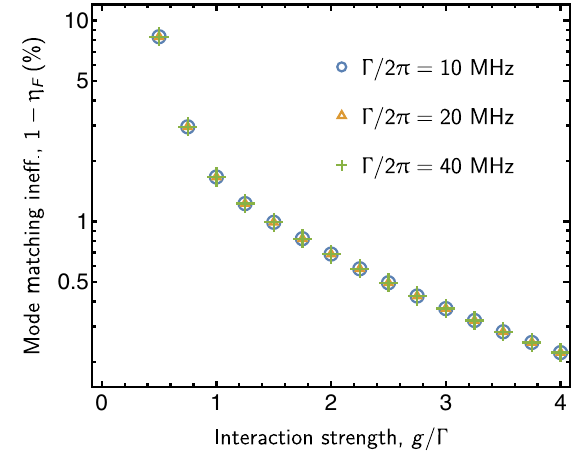
¼ 1 − F vs interaction strength e − ψ Þ = ðk ψ − ψ kÞ(cid:4) g e g e